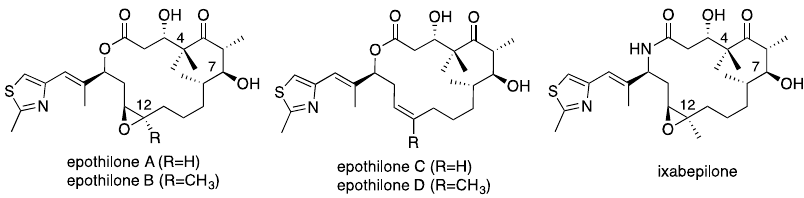
Figure 1. Naturally occurring epothilones A, B, C, and D and the semi-synthetic analogue